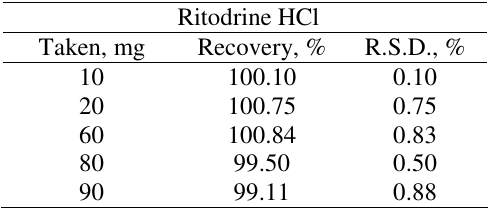
Table 3. Conductimetric determination of ritodrine HCl in pure solution.